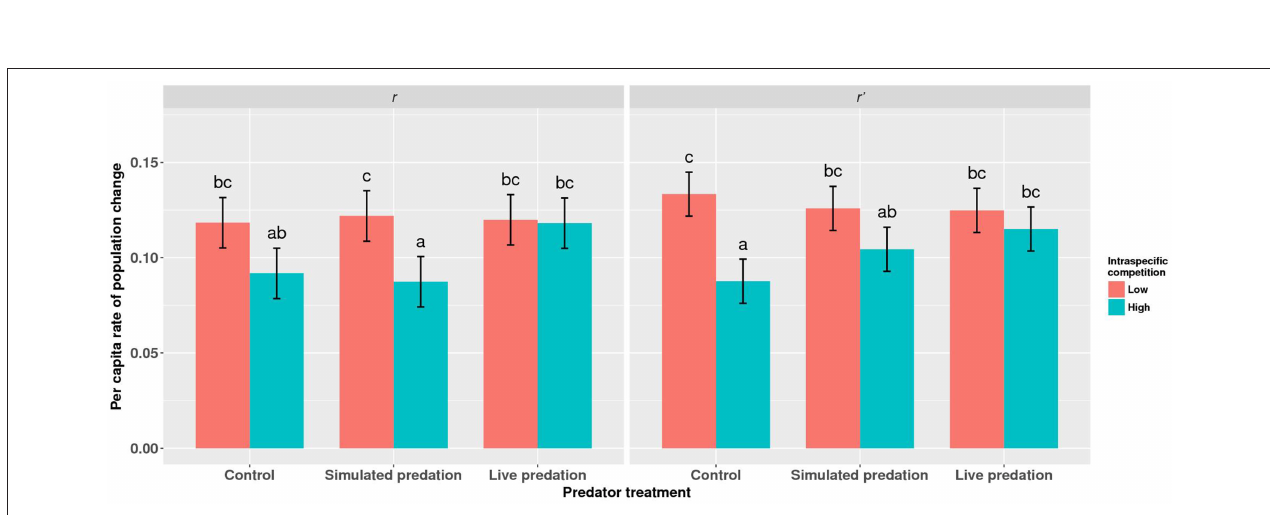
FIGURE 7 | Least squares means ( ± 95% CI) for per capita rate of population change ( r ) for cohorts of Aedes aegypti exposed to intraspecific competition and predation treatments as larvae. Data were statistically tested using a two-way ANOVA and results are summarized in Table 7 . Treatment means associated with the same letters are not significantly different in pairwise comparisons using Bonferroni adjustment for multiple